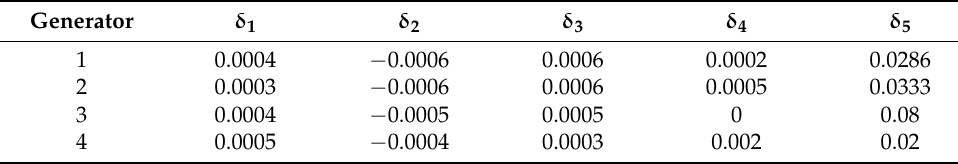
Table A4. Emission coefficients of the power-only units.